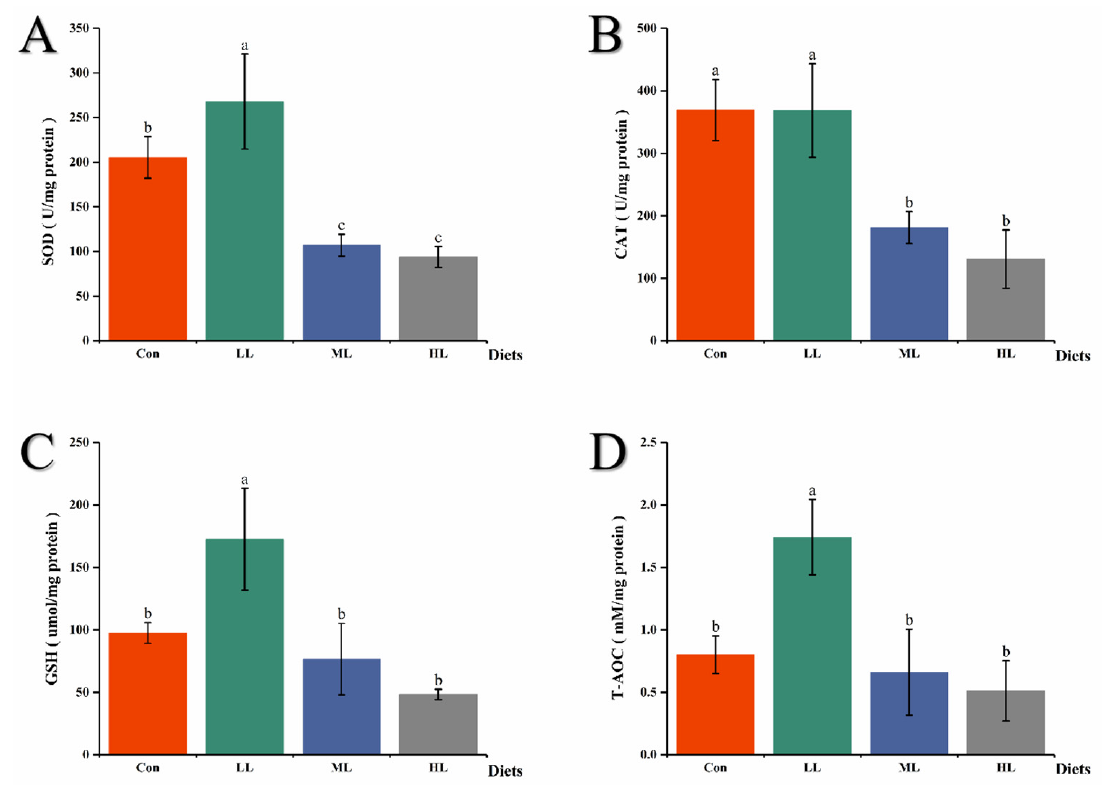
Figure 1. Antioxidant enzyme activities of the intestine in juvenile largemouth bass. ( A ) Superoxide dismutase; ( B ) Catalase; ( C ) Glutathione; ( D ) Total antioxidant capacity. Con means control diet. LL, ML, and HL mean 5 g Kg − 1 , 10 g Kg − 1 and 15 g Kg − 1 laminarin was supplemented into diets, respectively. Results are expressed as mean ± SEM ( n = 3). Means in the same row with different letters were significantly different among groups ( p < 0.05).